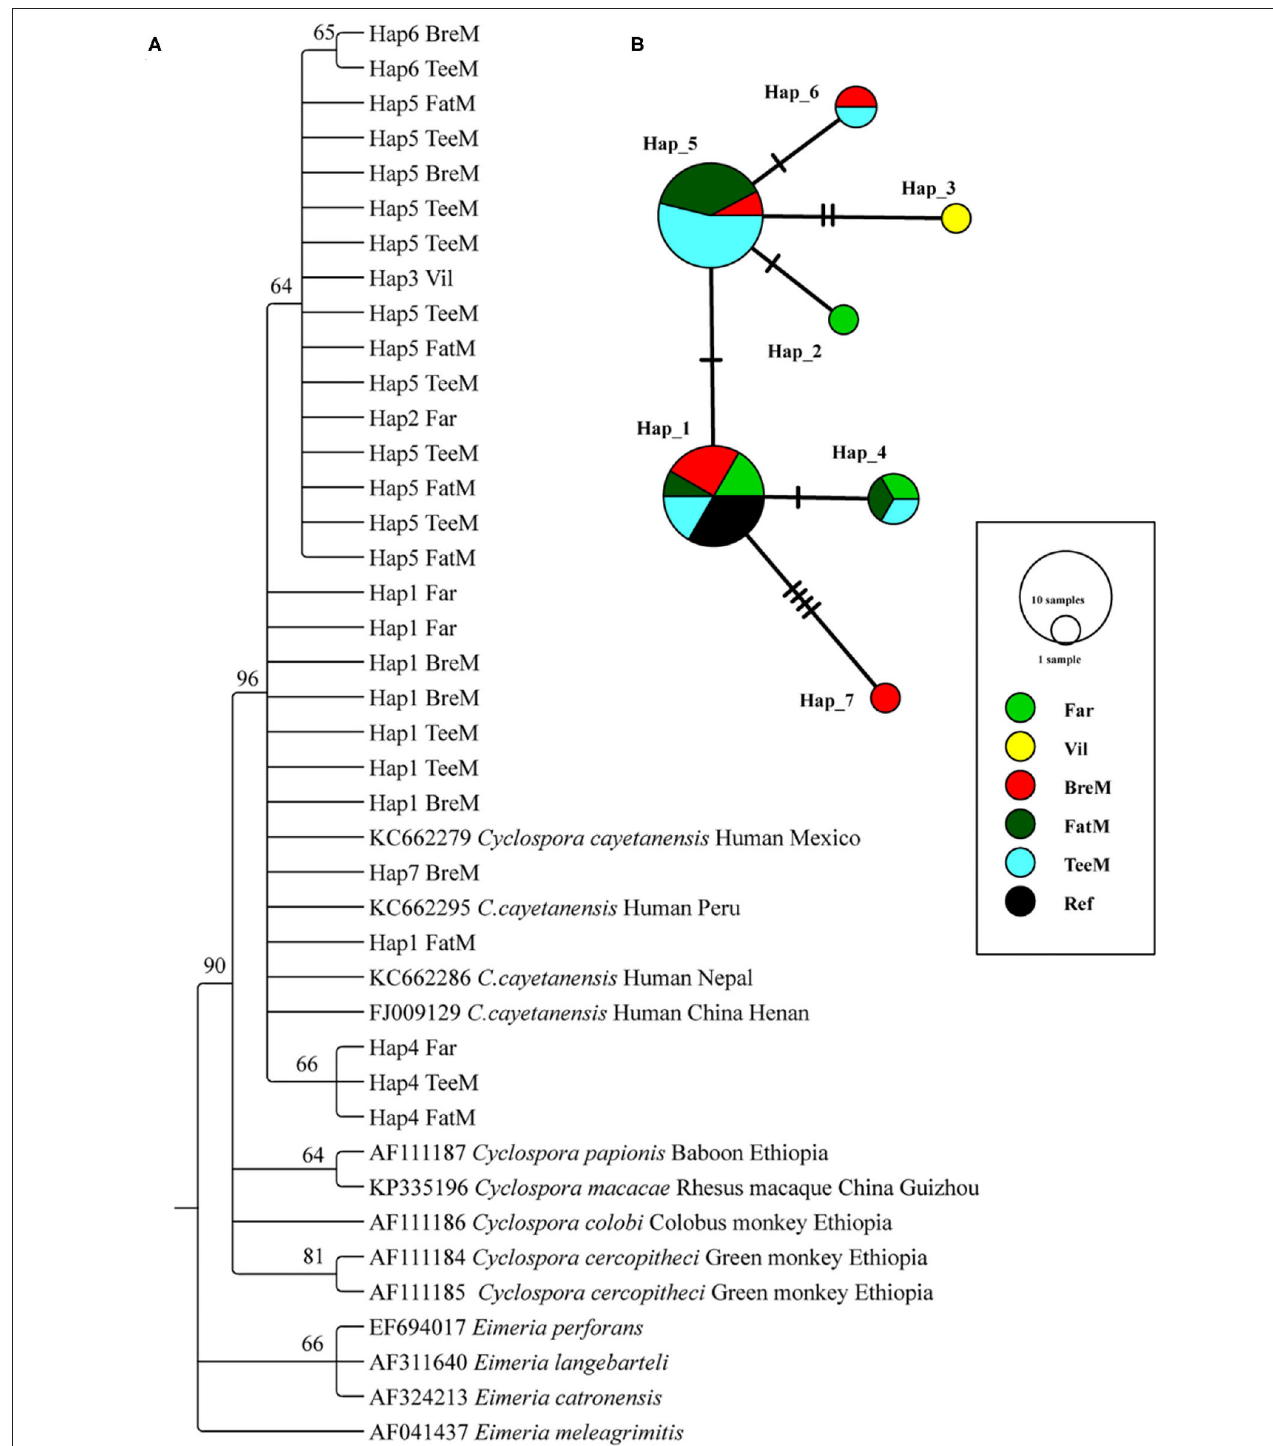
FIGURE 2 | Phylogenetic tree constructed using neighbor-joining (NJ) method and haplotype analysis network of Cyclospora cayetanensis based on 423 bp sequence of the partial SSU rRNA gene. (A) The phylogenetic analysis tree was constructed using the Kimura two-parameter model with 100 bootstrap replications. Eleven haplotype sequences were used in tree construction. (B) All the 28 sequences in this study and 4 published sequences of C. cayetanensis cluster were used to generate haplotype data. The network was constructed using TCS Network algorithm. Various colors represent different groups and the sizes of the circle represent the numbers of haplotypes. Far, facility worker; Vil, villager; BreM, breeding macaques; FatM, fattening macaques; TeeM, teenage macaques; AduM, adult male macaques; Ref, reference published sequences.